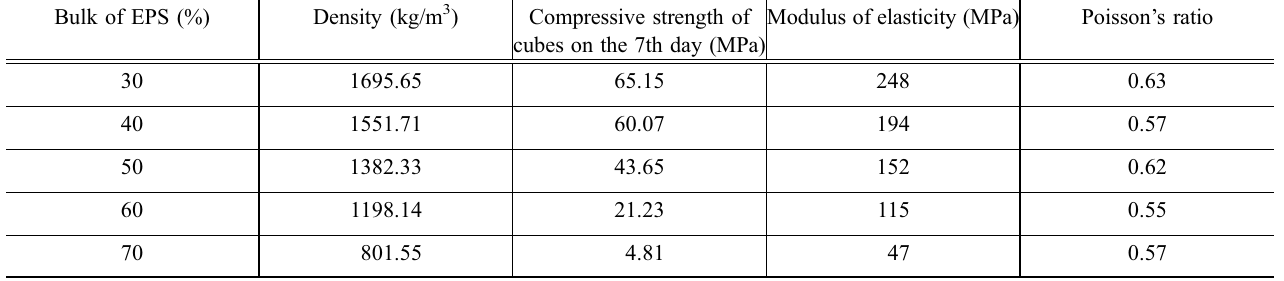
Table 3 Mechanical properties of HPEPC with different EPS bulk